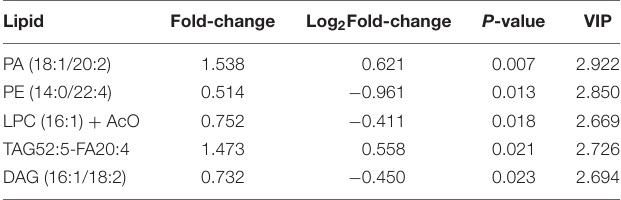
The lipids that meet both OPLS-DA analysis screening criteria (VIP > 1) and volcano plot analysis screening criteria (P < 0.05) were selected as the lipid components with significant